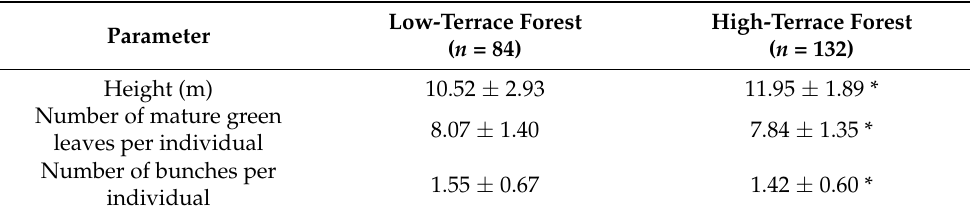
Table 2. Main characteristics of O. mapora in low-terrace and high-terrace forests in the Madre de Dios Region,